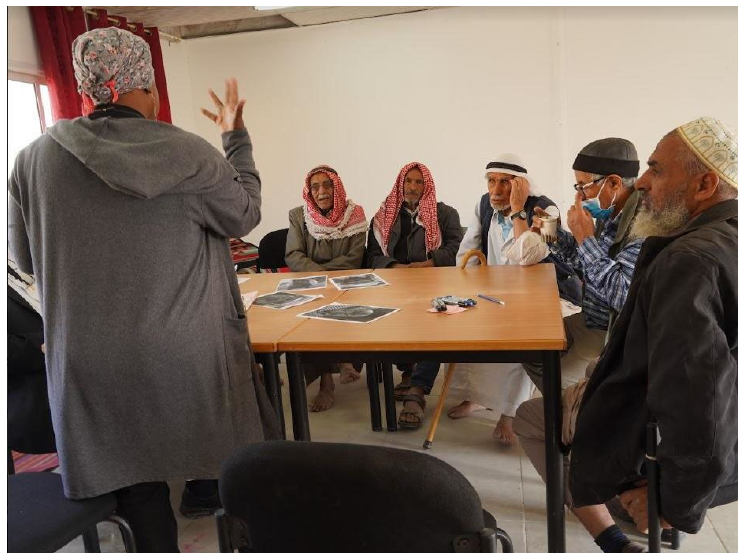
Figure 15. Kuseife elders participating in the Storyteller workshop, “Desert Sustainability and Art” Festival, Kuseife, 2021. Photographed by David Behar Perahia. Image courtesy of the artist.